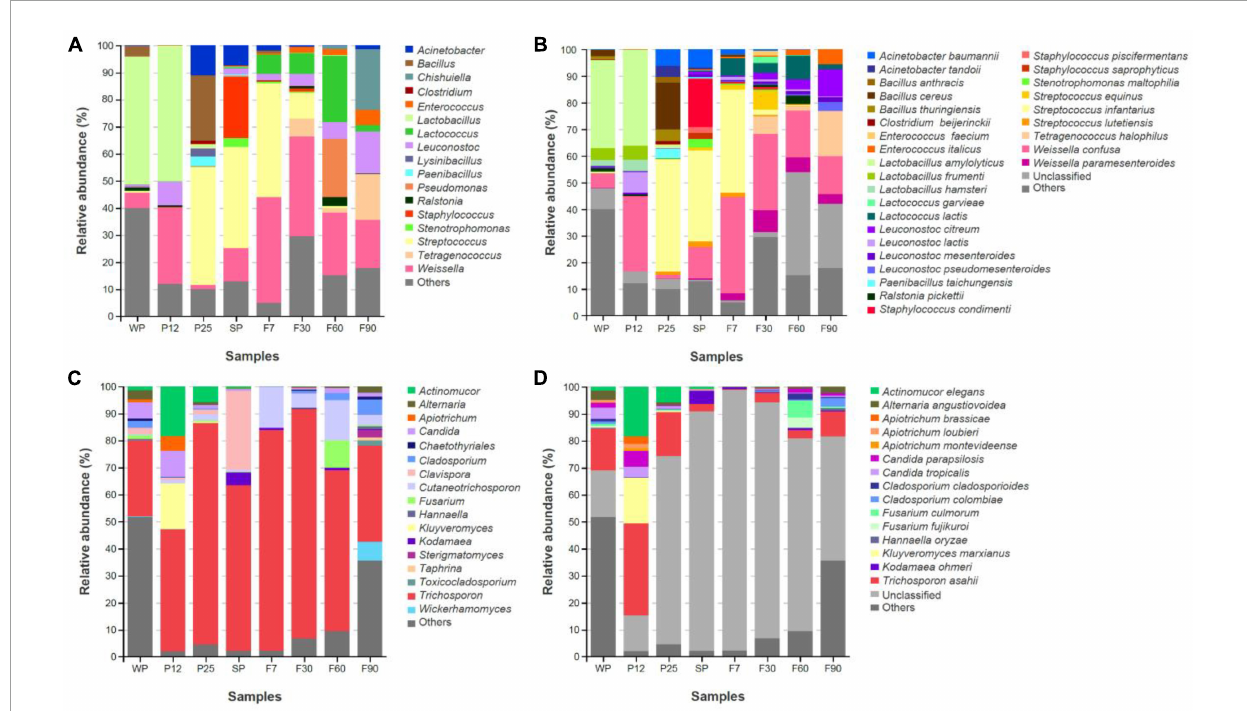
FIGURE6 Structure and succession of microbial community during fermentation of bacteria (A) and fungi (C) at the genus level; structure and succession of microbial community during fermentation of bacteria (B) and fungi (D) at the species level.